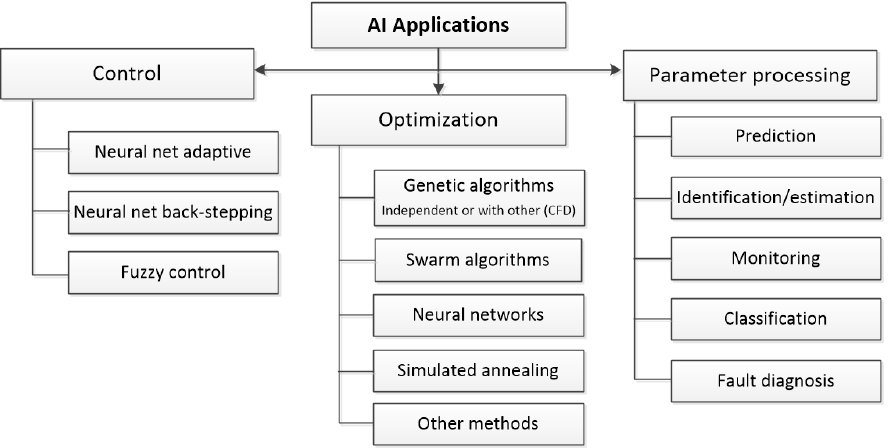
Figure 16. Main fields of AI applications in hydraulic system design.